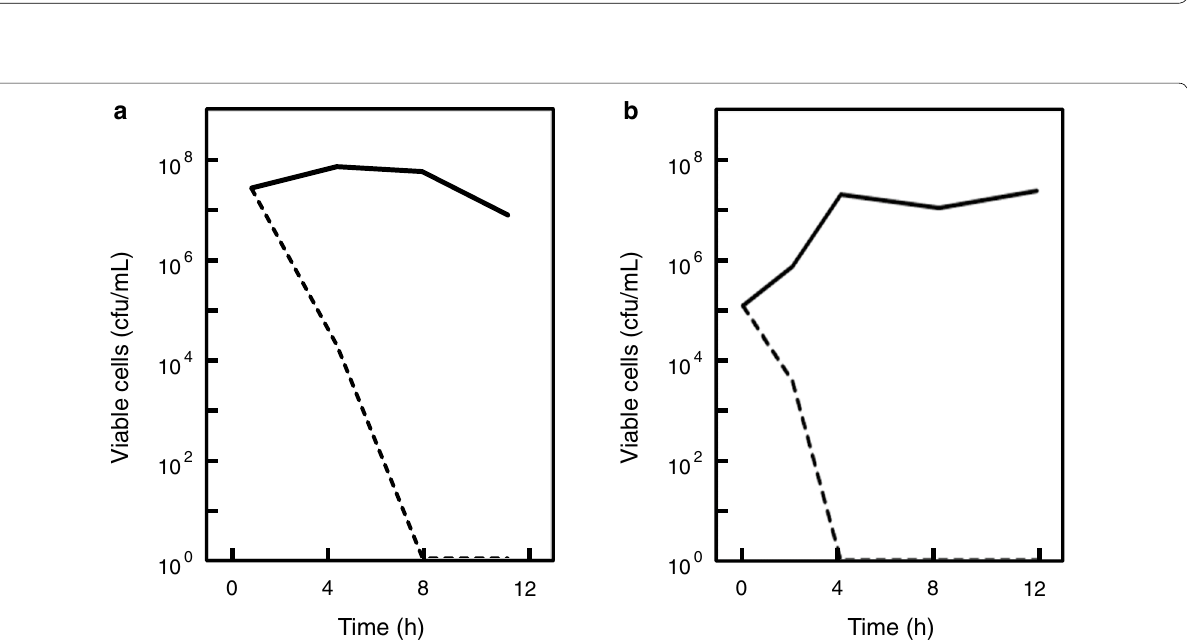
Fig. 4 Survival curves of B. subtilis strain in the presence and absence of the Natto peptide. a B. subtilis AHU 1708 T cells were pre‑cultured to a cell density of approximately 10 7 cells/mL in TH broth containing 5% (v/v) horse hemolysate. The Natto peptide was then added at a concentra‑ tion of 64 μg/mL. b B. subtilis AHU 1708 T cells were suspended at a cell density of approximately 10 5 cells/mL in TH broth containing 5% (v/v) horse hemolysate. The Natto peptide was then added at a concentration of 64 μg/mL, and the cells were cultured. Throughout the cultivation, the cultures were sampled, and culture aliquots were spread on TH agar supplemented with 5% (v/v) horse hemolysate, and cultured for 24 h. Grown colonies were then counted. Dashed lines indicate cell numbers in the presence of the Natto peptide. Solid lines indicate cell numbers in the absence of the Natto peptide. Each experiment performed at least three times, and the representative results are presented. The similar results were observed in the same